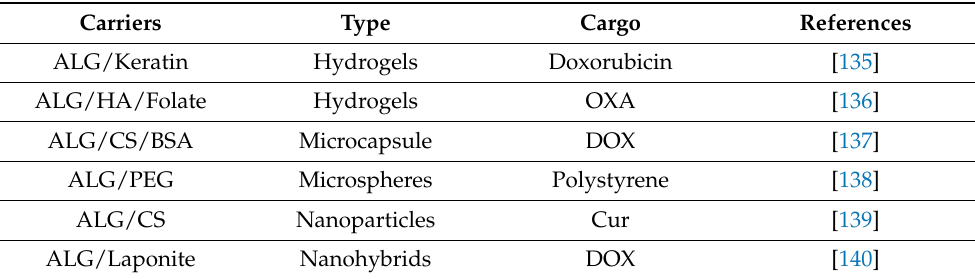
Table 5. Various alginate-based vehicles used in drug